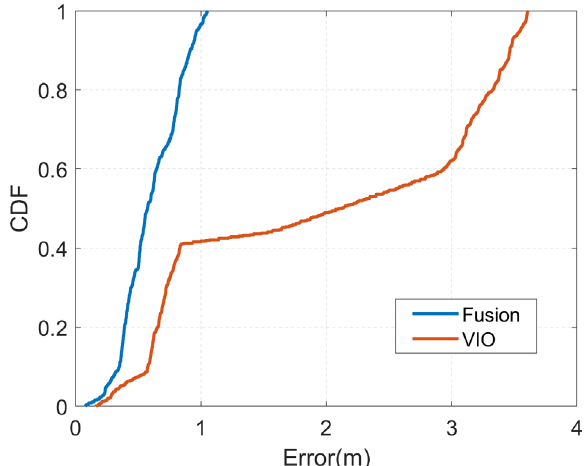
Figure 14. CDF of positioning errors with different method of the conference room.